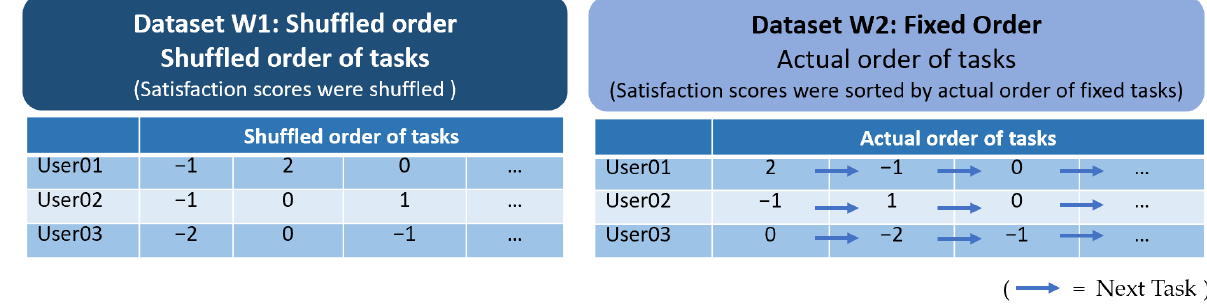
Figure 8. Example of the structure in each dataset.